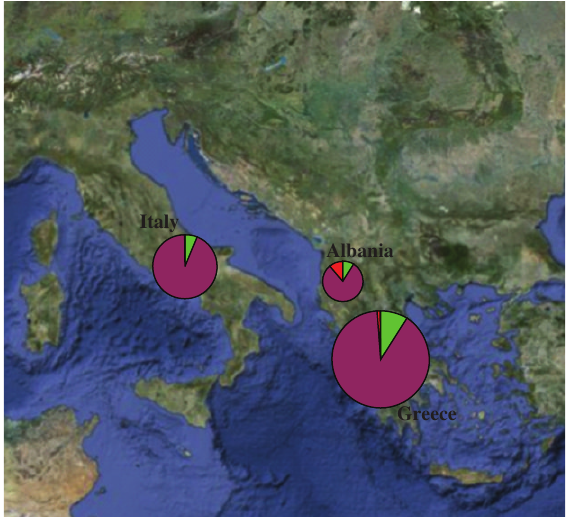
FIGURE 2: Geographical distribution of haplogroups, circles are proportional to the number of samples. (green: haplogroup A; purple: haplogroup B; red: haplogroup